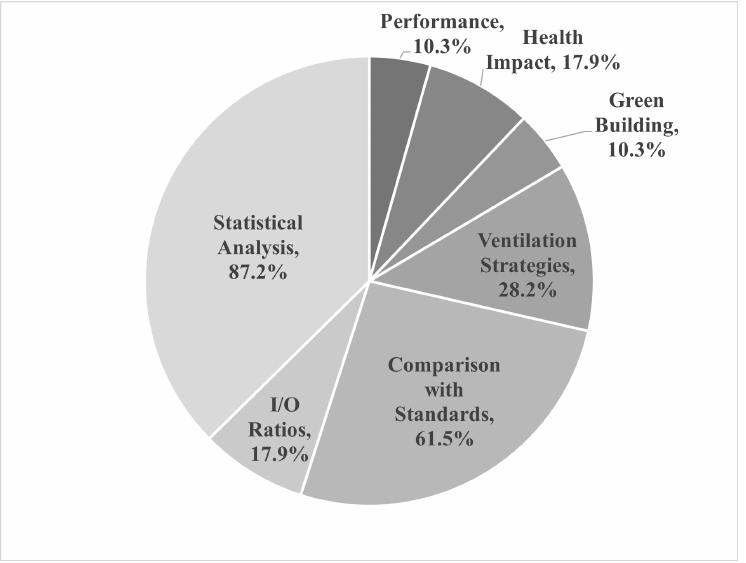
Figure 9. Considered outcomes for the examined field measurement